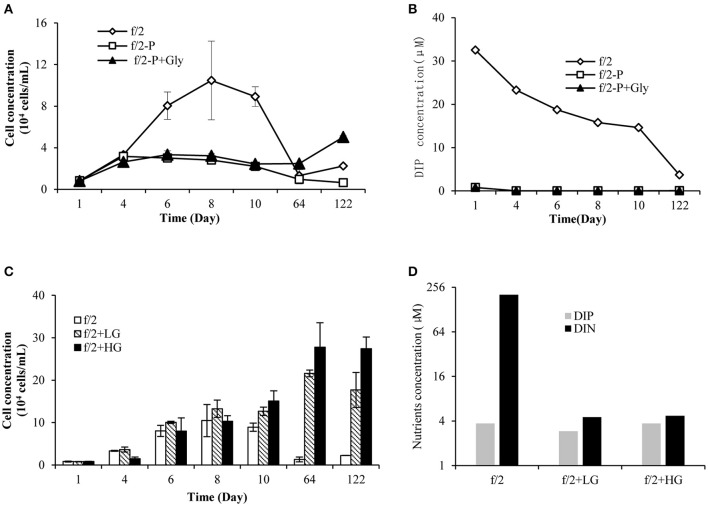
Growth and nutrient conditions of P. donghaiense in all experimental settings used in this study. (A) Growth of P. donghaiense in cultures f/2, f/2−P, and f/2−P+Gly; (B) DIP concentrations in cultures f/2, f/2−P, and f/2−P+Gly; (C) Growth of P. donghaiense in cultures f/2, f/2LG, and f/2HG; (D) DIP and DIN concentrations in cultures f/2, f/2LG, and f/2HG on day 122.